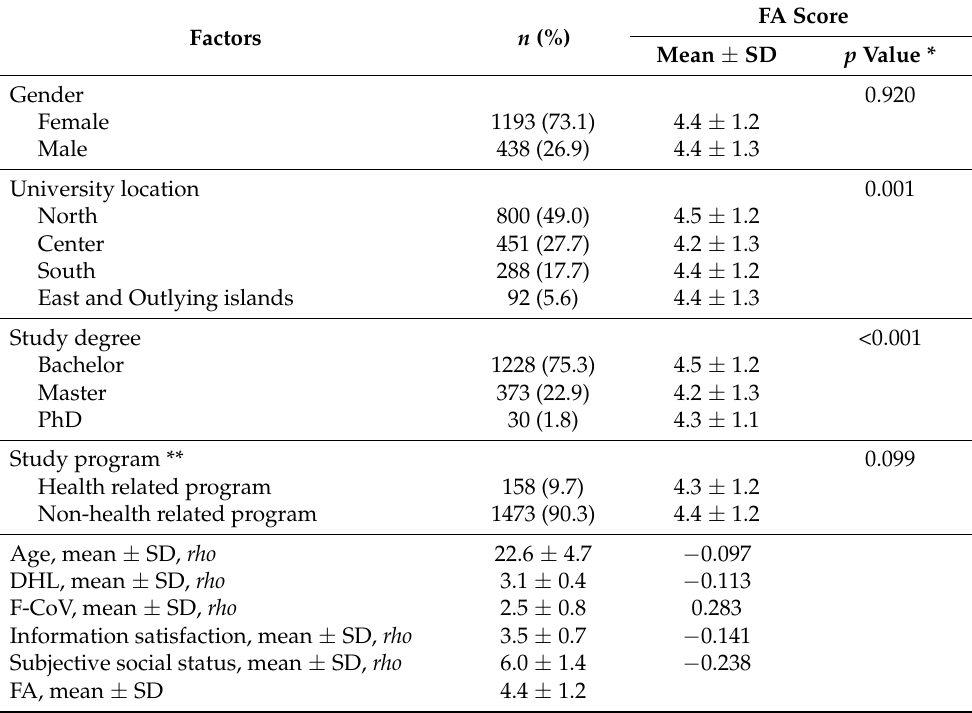
Table 2. Participants’ characteristics and future anxiety ( n =